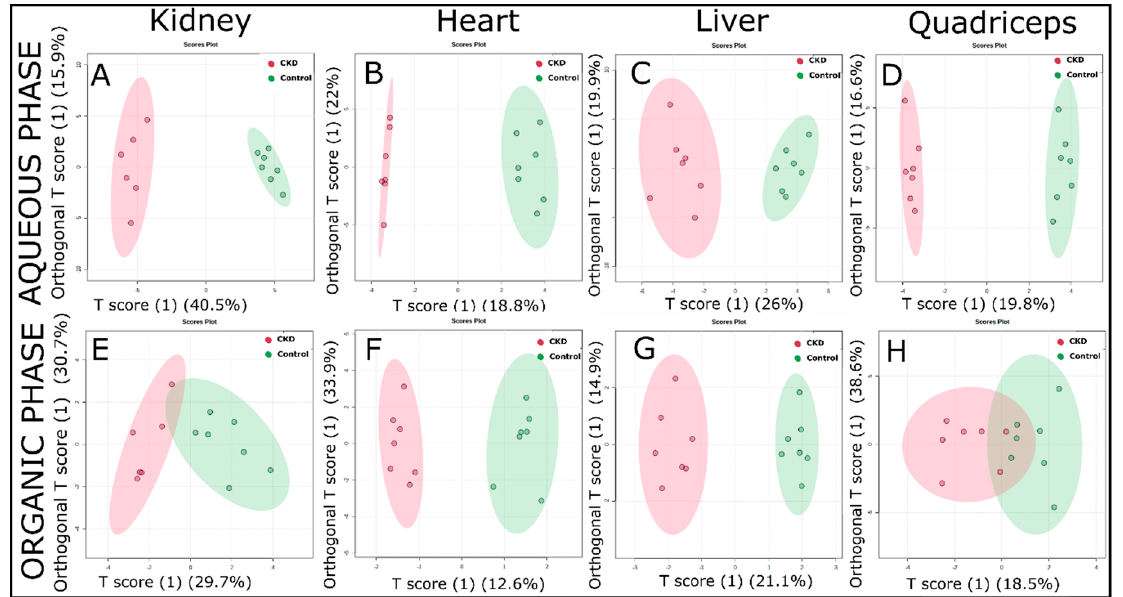
Figure 4. Orthogonal projections to latent structures discriminant analysis (OPLS-DA) score plots obtained from the 1 H- NMR spectra of the extracted tissue samples (using the targeted profiling approach) from the control and adenine-induced CKD groups. ( A – D ) The OPLS-DA score plots from the aqueous phase samples for the kidney, heart, liver, and quadriceps, respectively. ( E – H ) The OPLS-DA score plots from the organic phase samples ( n = 7/group).